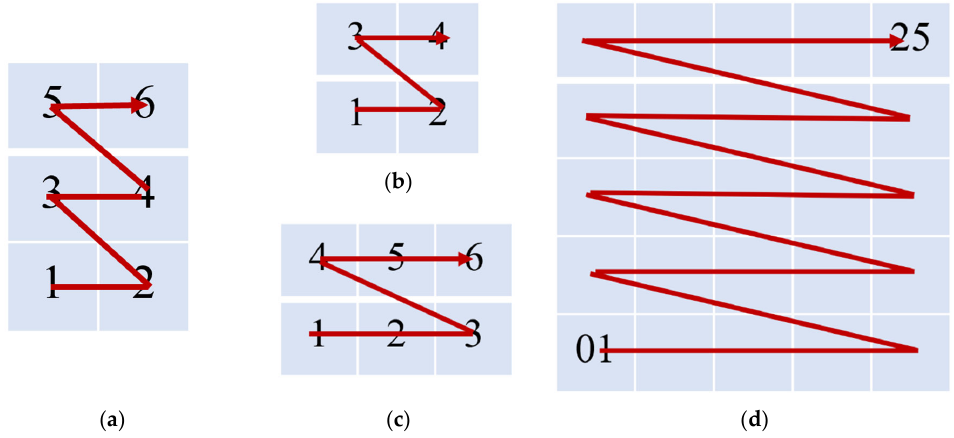
Figure 4. Four different types of fill curves: ( a ) 2 × 3 profiling; ( b ) 2 × 2 profiling; ( c ) 3 × 2 profiling; ( d ) 5 × 5 profiling.